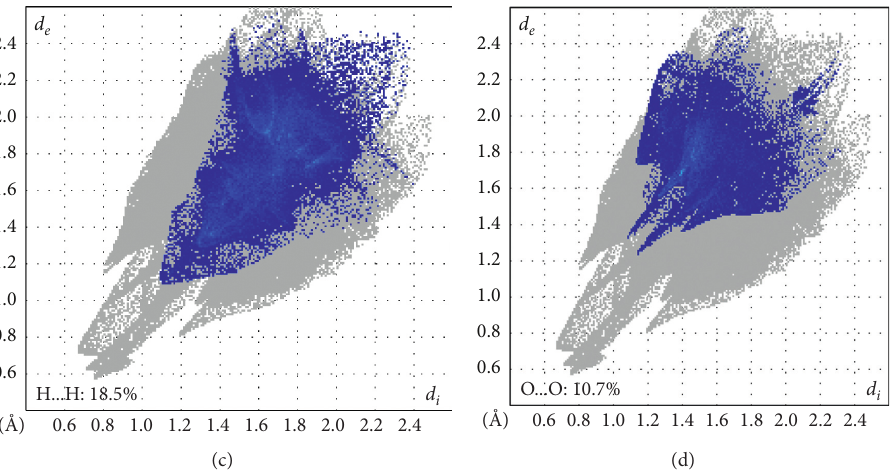
Figure 6: 2D fingerprint plots of the studied compound resolved into all contacts (a) and O ... H/H . .. O (b), H .. . H (c), and O . .. O (d)